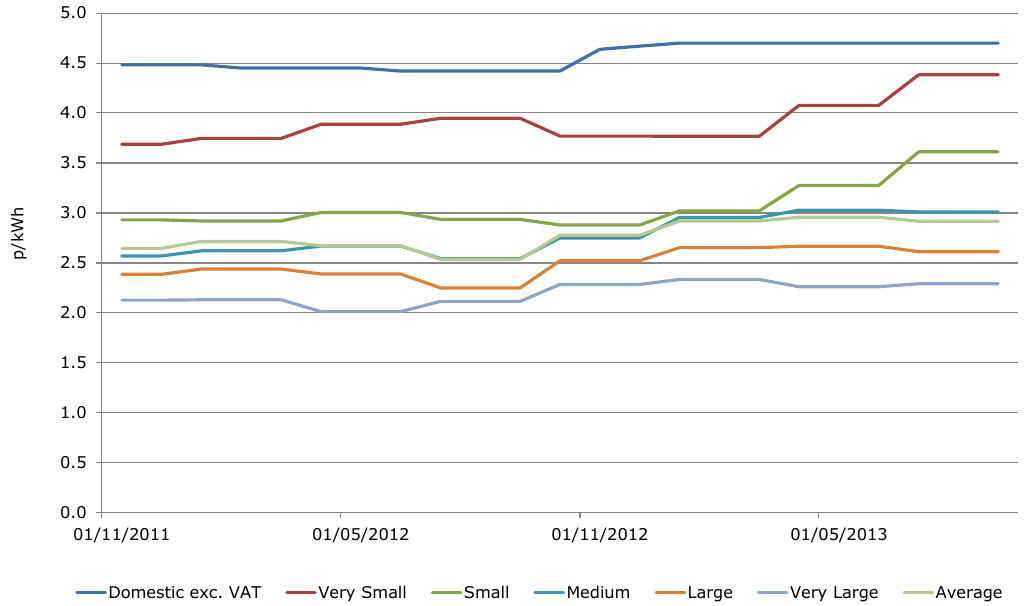
Source: Non-domestic prices: DECC QEP. Non-domestic prices (excluding VAT) are based on DECC survey of energy suppliers. Prices include the Climate Change Levy. Domestic prices: Ofgem SMI as of November 2013, based on a consumption value of 15300 kWh, not adjusted for falling consumption over time, and excluding